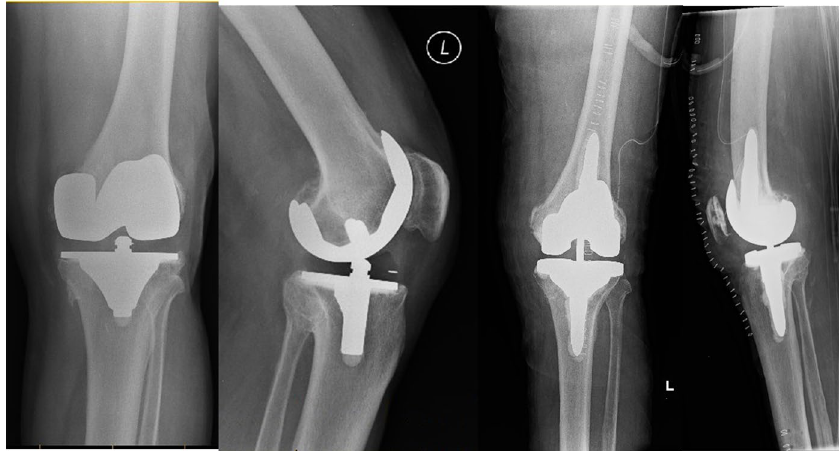
Fig. 18 Pre‑ and postoperative radiographs of patient for preoperative planning in Fig.